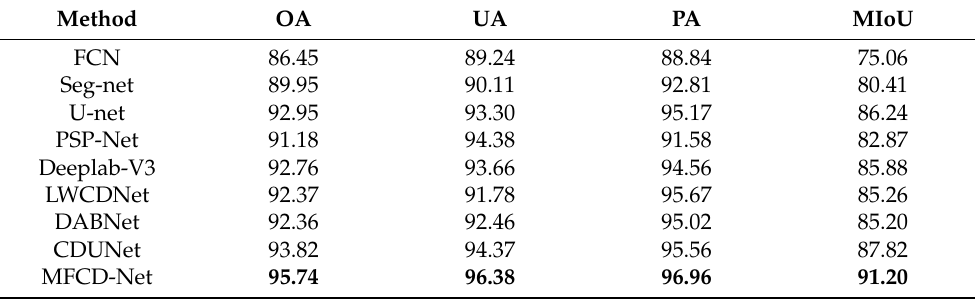
Table 3. Cloud detection accuracy of different methods (%).